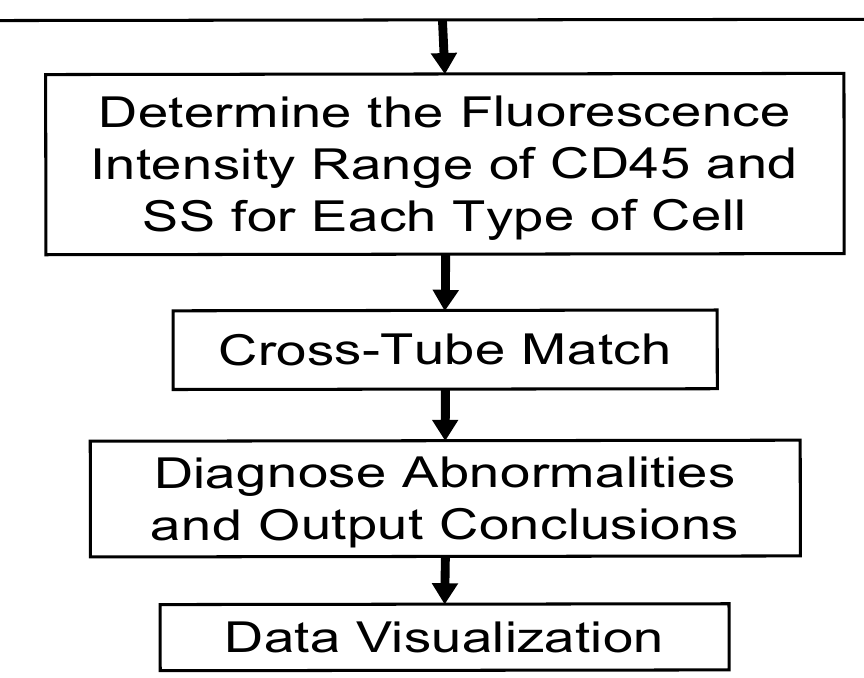
Figure 1. Workflow of MFC